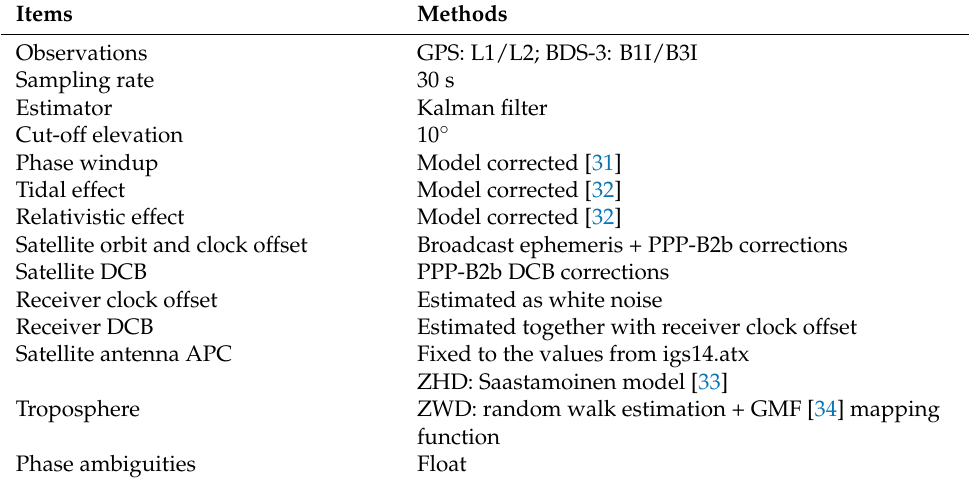
Table 3. Processing strategies for the